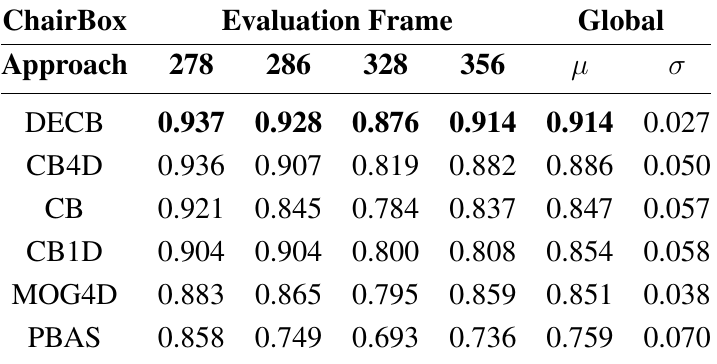
Table 2. Segmentation evaluation for sequence, ChairBox. The table shows F five studied approaches on four different evaluation frames, the mean and standard deviation on the entire